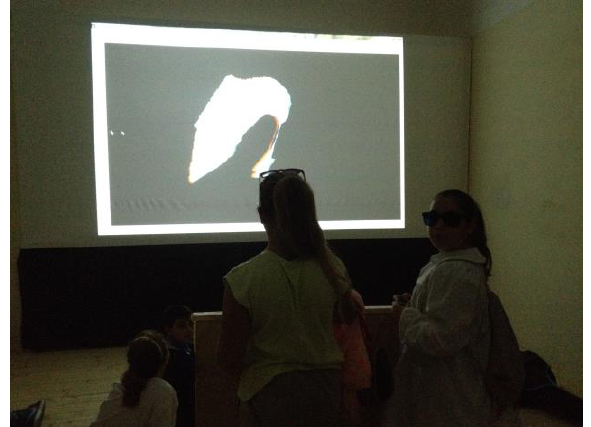
Figure 20. Immersive room in the exhibition at TERRA, Terra Murata in